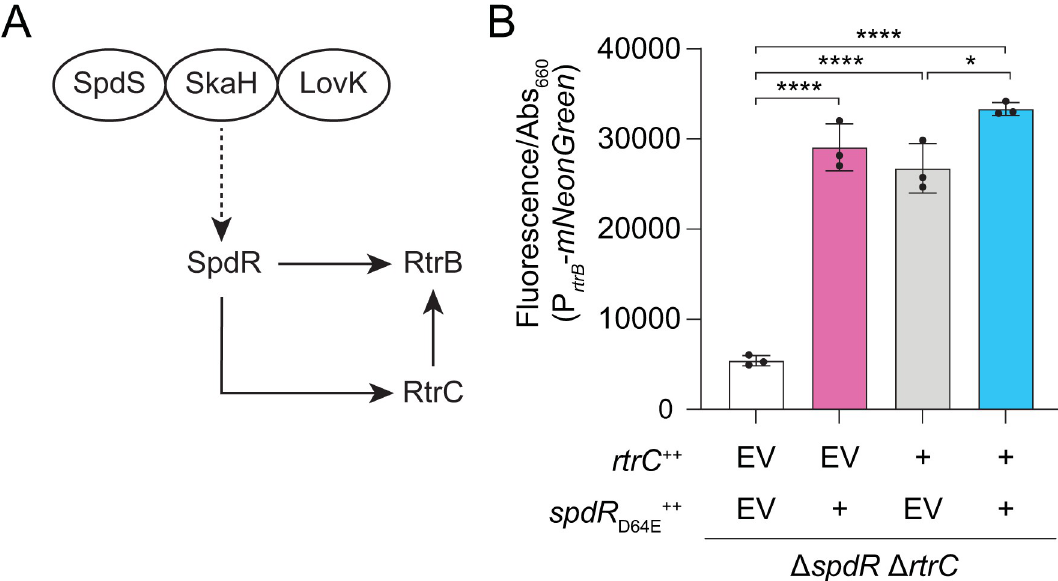
Fig 6. spdR - rtrC - rtrB form an OR-gated type I coherent feedforward loop. A) Schematic of the Type I coherent feedforward loop. The sensor histidine kinases SpdS, SkaH, and LovK function upstream and regulate the DNA-binding response regulator, SpdR [16]. SpdR can activate transcription of both rtrC and rtrB ; RtrC activates transcription of rtrB . Dashed arrows indicate post-transcriptional activation and solid arrows indicate transcriptional activation. B) rtrB transcription measured using a P transcriptional reporter. Reporter strains were built in a background in which rtrC and spdR are deleted from the chromosome ( Δ spdR Δ rtrC ). Transcription was measured in empty vector (EV), rtrC , or spdR D64E overexpression (++) backgrounds. Cells were grown in complex medium (PYE) and fluorescence signal was normalized to cell density (OD 660 ). Data are the mean; errors bars represent standard deviation of three biological replicates. Statistical significance was determined by one-way ANOVA followed by Tukey’s multiple comparisons test (p-value � 0.05, � ; p-value � 0.0001, ����